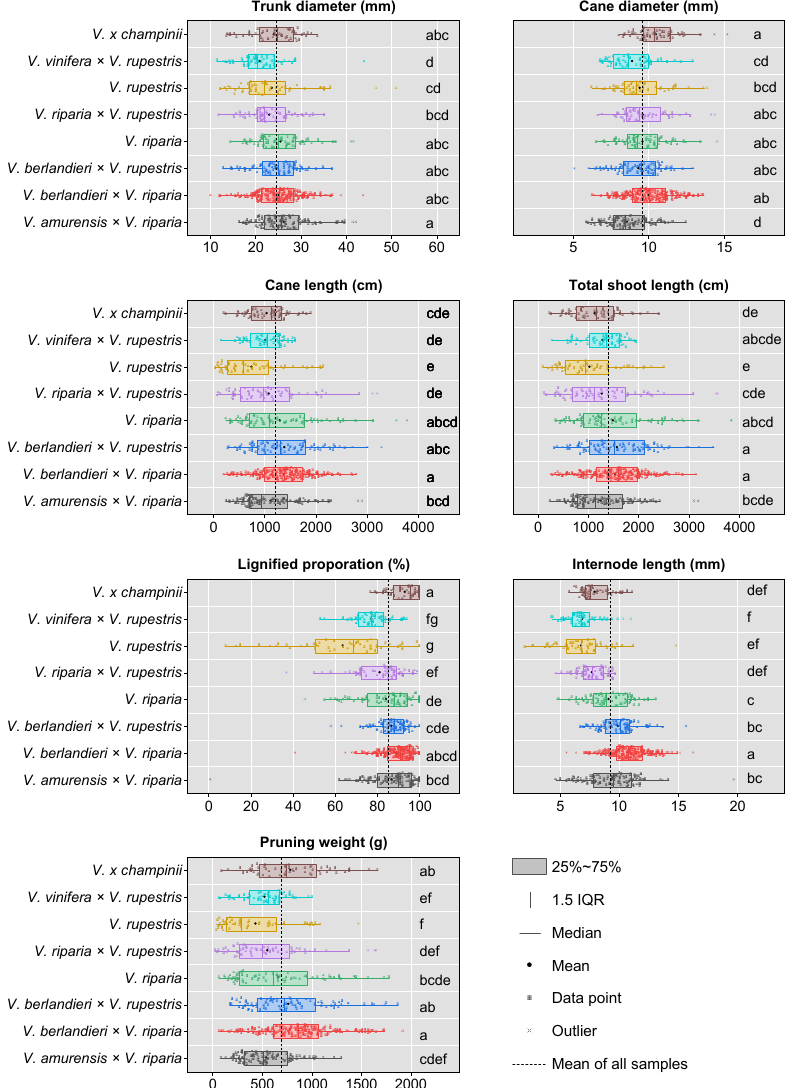
Figure 5. A comparison of the effects of eight parentages on the growth indicators of adult vines. Different lowercase letters on each figure indicate significant differences at p < 0.05 (adjusted by Bonferroni correction) by the nonparametric median test. Each data point corresponds to a single plant in one of the seasons. IQR, interquartile